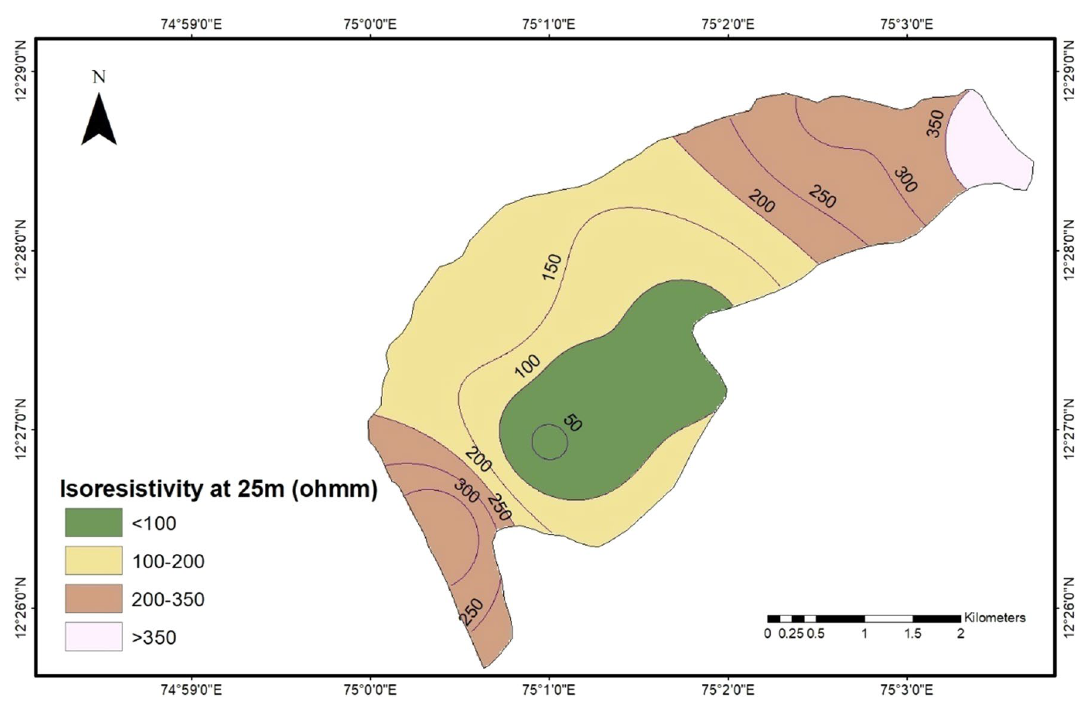
Fig. 11 Isoresistivity at 25 m depth of Kalanad river